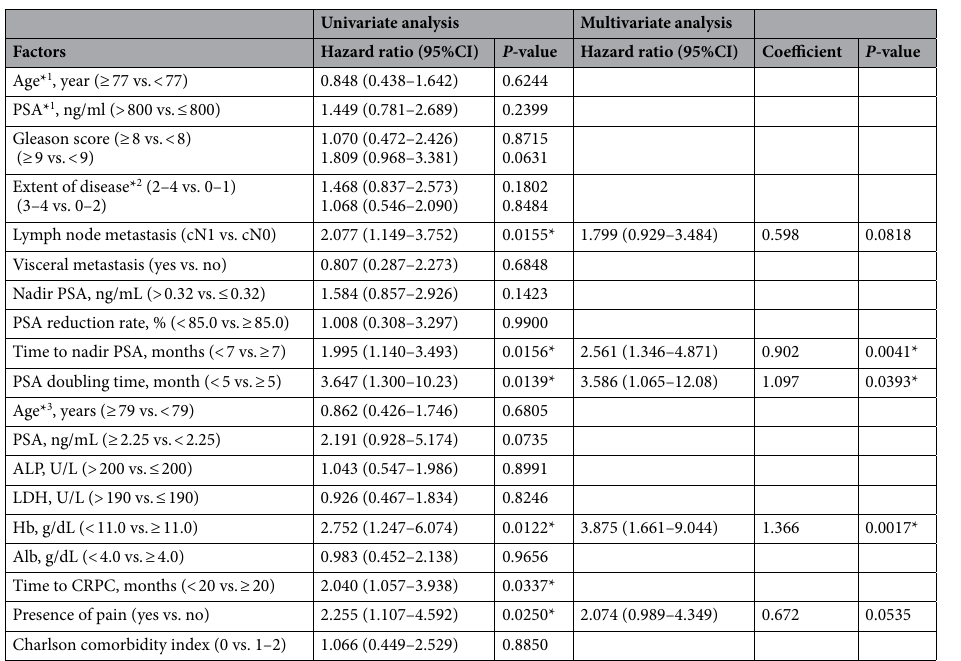
Figure 1. Treatment sequences of the patients in the present cohort. CRPC castration-resistant prostate cancer; ARAT androgen receptor-axis targeted therapies.